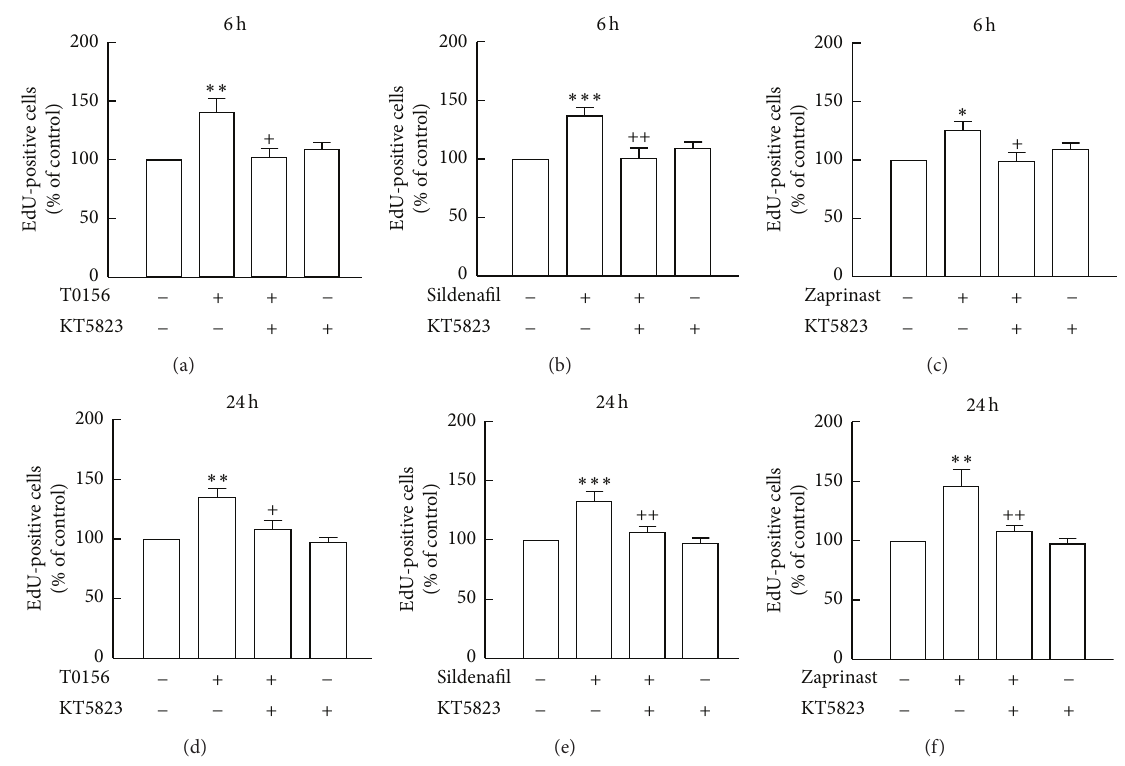
Figure 5: Inhibition of PKG prevented the proliferation of SVZ cells stimulated by PDE5 inhibitors. Cell proliferation following treatment with 1 𝜇 M KT5823 and 1 𝜇 M T0156 (a, d), 1 𝜇 M sildenafil (b, e), or 10 𝜇 M zaprinast (c, f) was assessed by incorporation of EdU and evaluated by flow cytometry, following 6 h or 24 h of treatment. Data are expressed as means ± SEM of at least 4 independent experiments. One-way ANOVA (Bonferroni’s post-test), ∗ 𝑃 < 0.05 , ∗∗ 𝑃 < 0.01 and ∗∗∗ 𝑃 < 0.001 , significantly different from control and + 𝑃 < 0.05 and ++ 𝑃 < 0.01 significantly different from the PDE5 inhibitor.